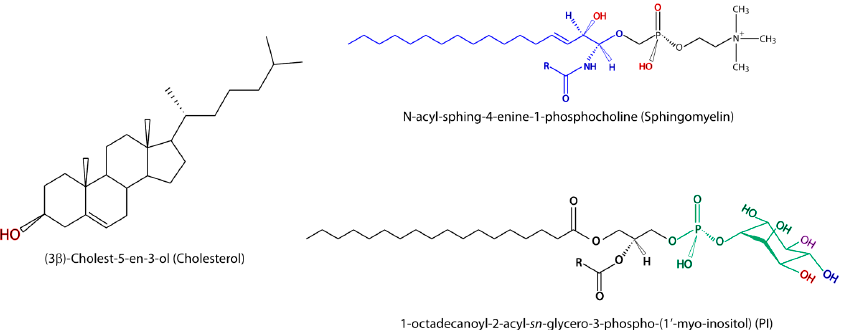
Figure 2. Structure of the most relevant lipids in virus infection is illustrated. Hydroxyl (HO) and oxygen (O) atoms potentially involved in the interaction with the fusion peptide or fusion loop are marked in red in cholesterol and sphingomyelin. The basic ceramide structure is marked in blue in the sphigomyelin structure. In phosphatidylinositol (PI), the hydroxyl groups that can be esterified with phosphate at the positions 3, 4, and 5 of the myo-inositol group to render PIP (PI3P or PI4P), PIP2 (PI(3,4)P or PI(4,5)P), and PIP3 (PI(3,4,5)P), which are marked in red, blue, and violet, respectively, are